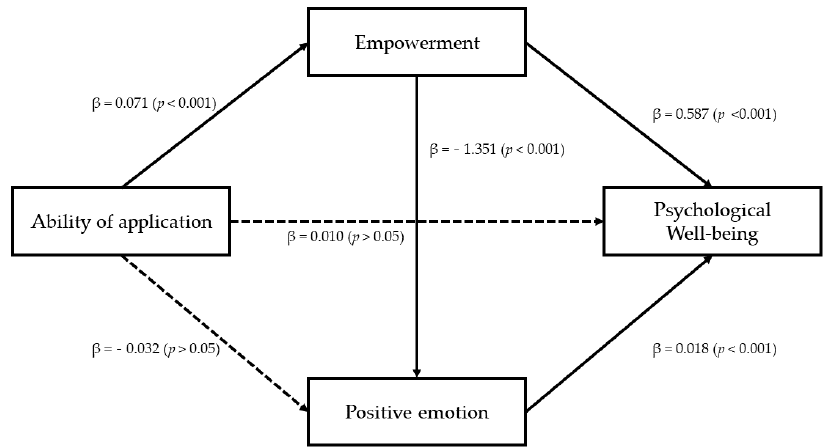
Figure 3. The result of verification of the double mediating effect of empowerment and positive emotion.